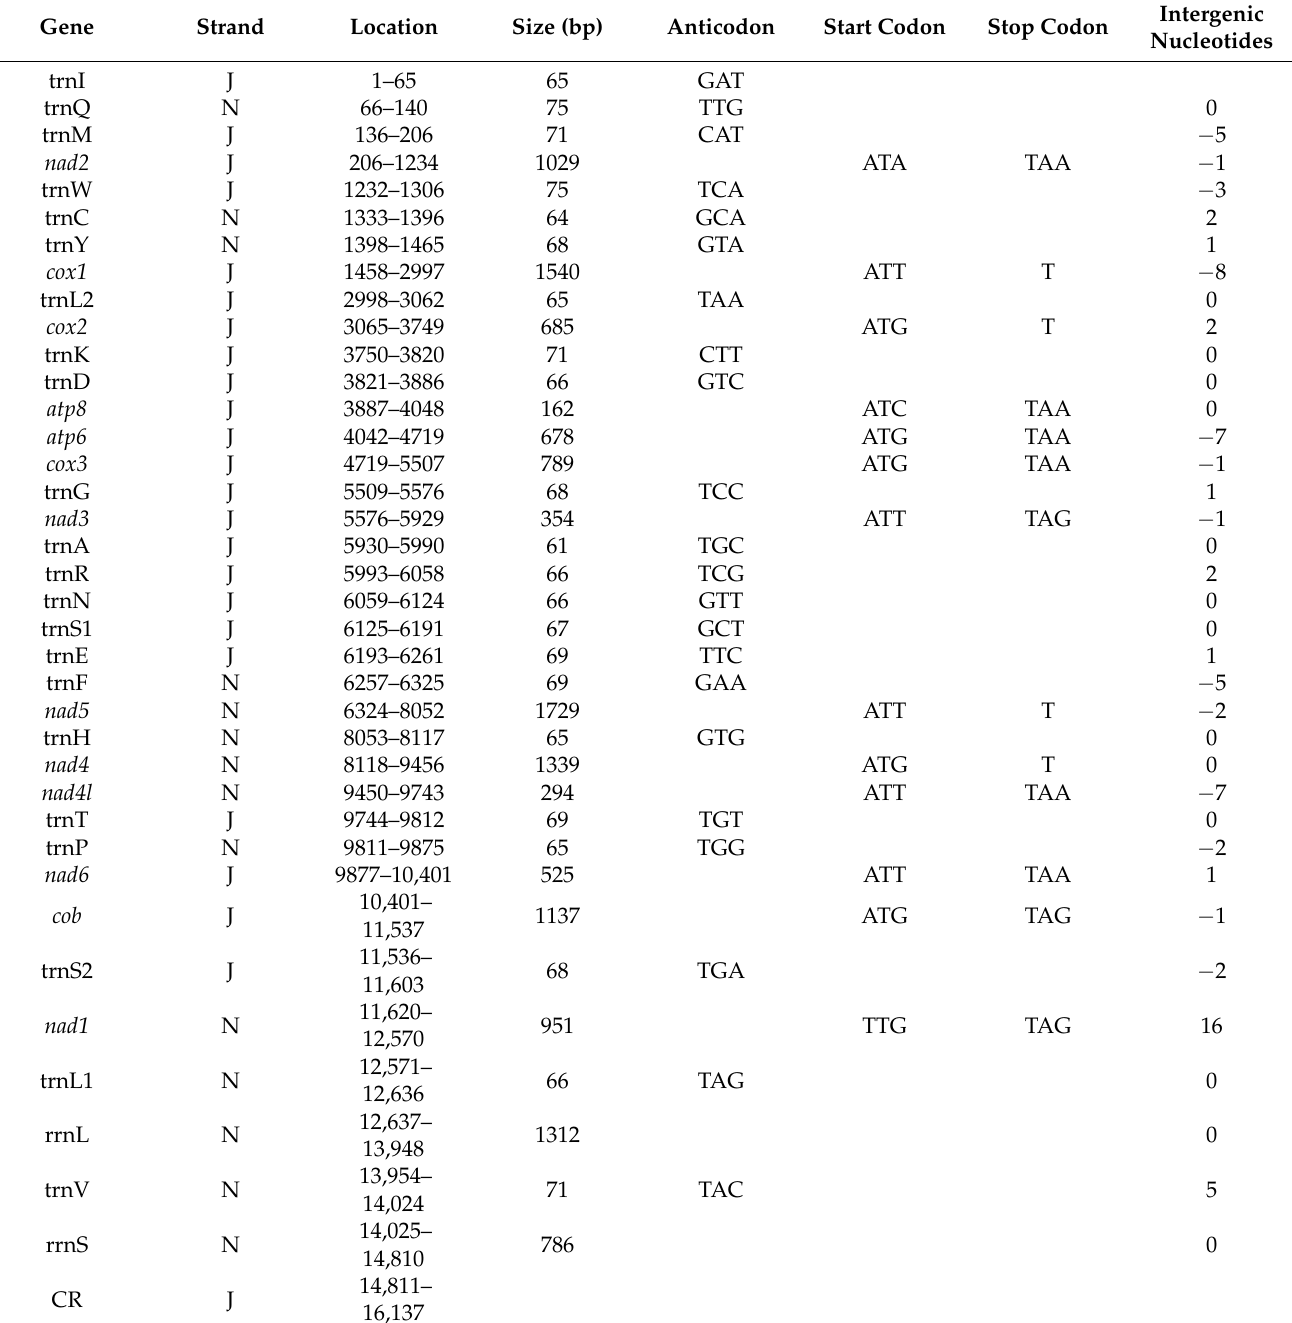
Table 3. Organization of G. orientalis